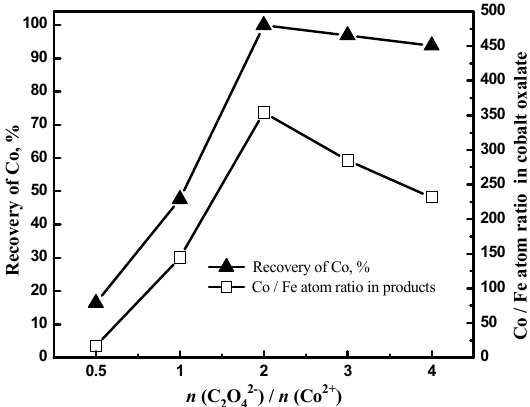
Figure 10. Effect of dosage of sodium oxalate on preparation of cobalt oxalate product in a low concentration solution.